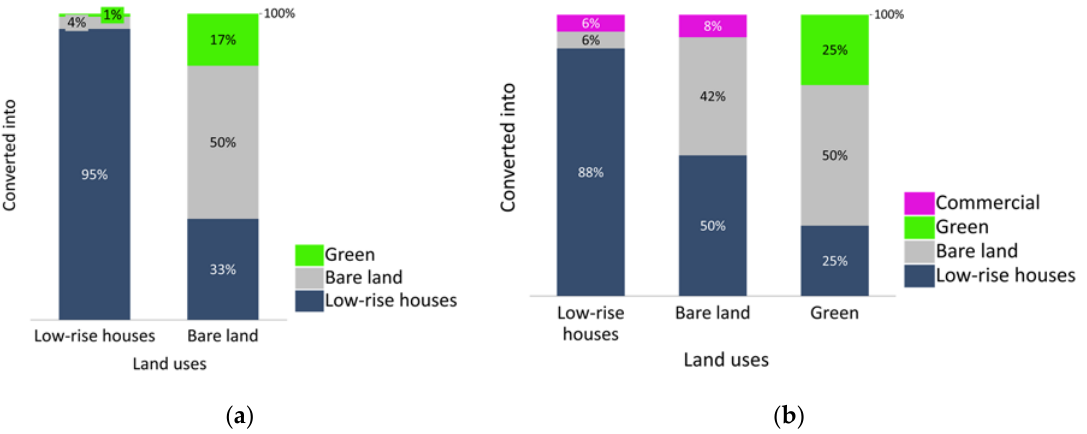
Figure 8. ( a ) The land use conversion matrix between 2002 and 2012 in Altad. ( b ) The land use conversion matrix between 2012 and 2020 in